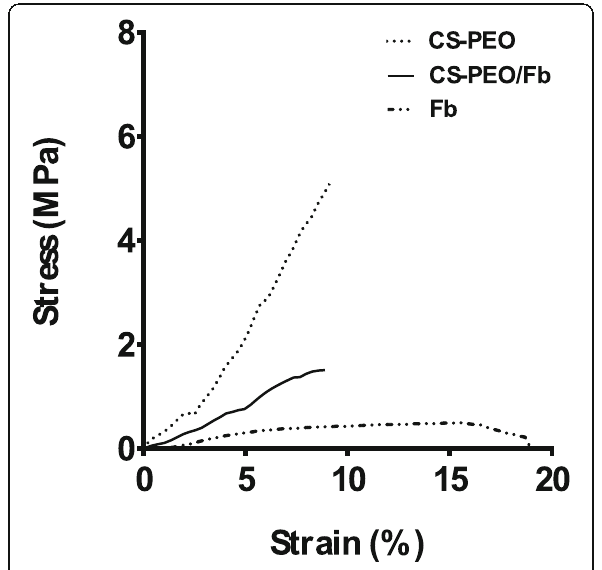
Fig. 6 Stress-strain curves of CS-PEO, CS-PEO/Fb, and Fb scaffolds. Data are representative of ten independently produced scaffolds